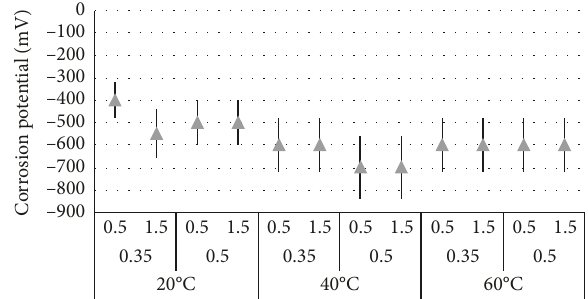
Figure 4: Characteristic values of corrosion potential.